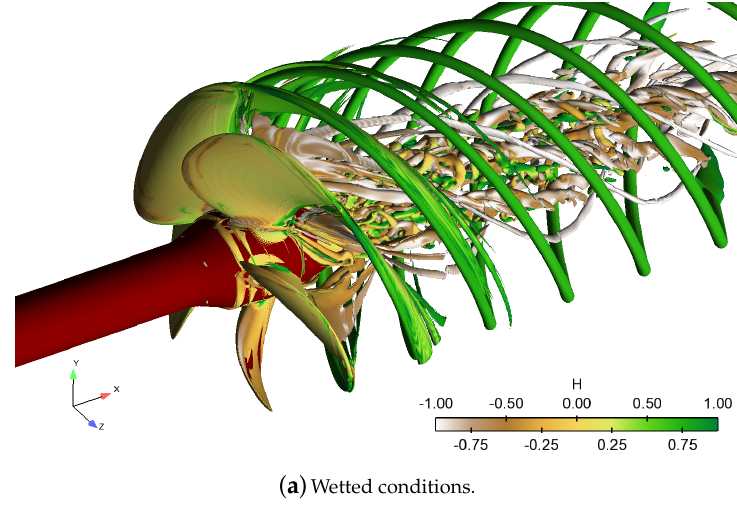
Figure 16. Distribution of non-dimensional velocity near the propeller on the cut plane y = 0. In the cavitating case, the iso-surface of the void fraction α = 0.1 is coloured by light